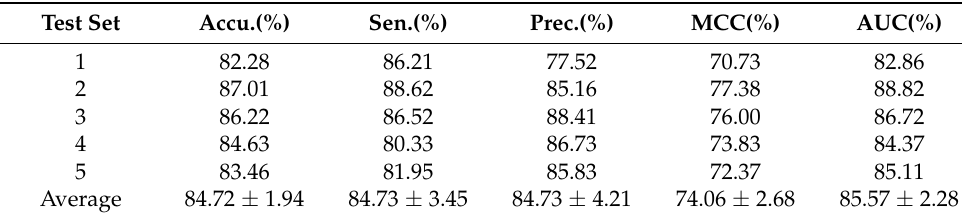
Table 3. 5FCV prediction results obtained by RoFDT on the GPCR dataset.